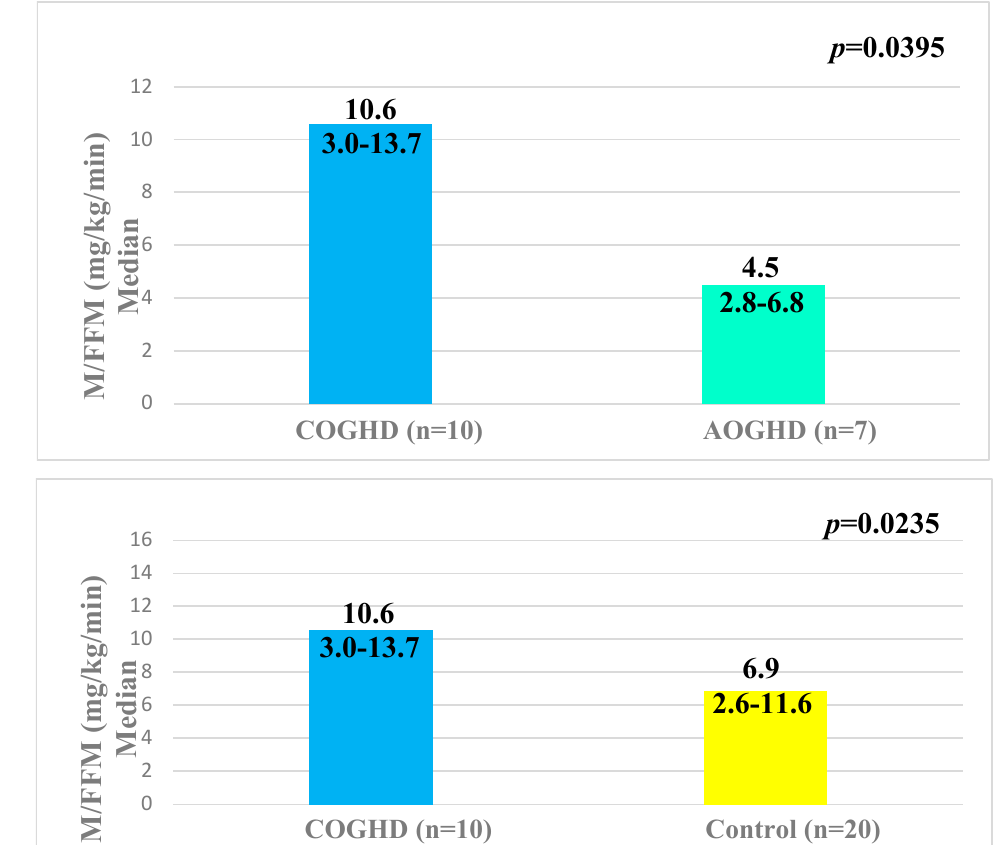
Figure 1. Insulin sensitivity in patients with COGHD vs. AOGHD, COGHD vs. control subjects COGHD and AOGHD vs. control subjects AOGHD. M/FFM was adjusted for age and BMI. Abbreviations: COGHD: patients with childhood-onset GH deficiency; AOGHD: patients with adulthood-onset GH deficiency; M/FFM: M-value normalized per kg free fat mass. The data refer to the median, minimum, and maximum. 3.3. Comparative Analysis between COGHD Patients and Respective Control Group These groups did not present differences in age, sex, and BMI. Fasting glucose and IGF-1 levels were lower in patients with COGHD than in controls. When body composition was analyzed, patients with COGHD had a higher PFM and lower PFFM, compared with the control group (Table 2). Regarding IS, we found higher M/FFM values among patients with COGHD compared to the individuals of the control group (Figure 1 and Figure 2).